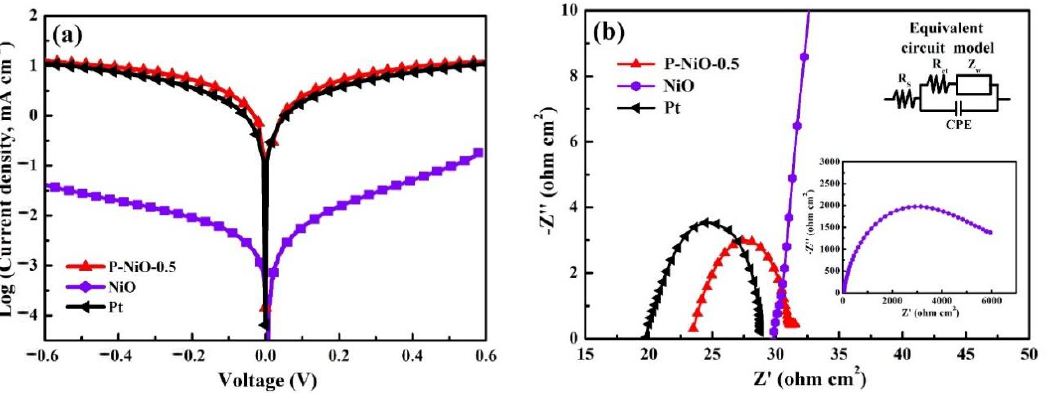
Figure 6. ( a ) Tafel polarization plots and ( b ) electrochemical impedance spectra of P-NiO-0.5, NiO and Pt